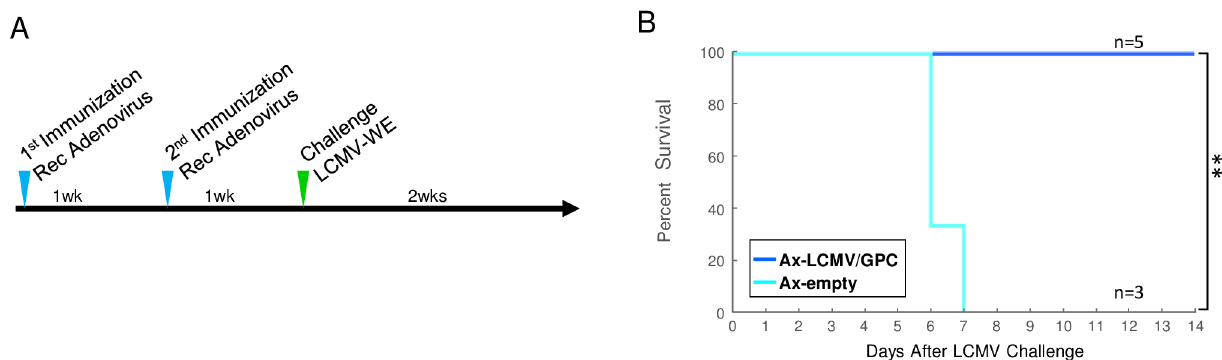
Fig 7. Survival curves in mice inoculated with adenovirus vectors before LCMV-WE infection. (A) The schedules of immunization with adenovirus and LCMV challenge in C57BL/6 mice. Mice were inoculated twice with Ax-LCMV/GPC or Ax-empty at 1-week intervals. One week after the last inoculation of adenovirus, mice were challenged with 10 PFU of LCMV-WE and observed for 2 weeks. (B) The survival curve of mice inoculated with Ax-LCMV/GPC or Ax-empty. Asterisks indicate a significant difference (p <